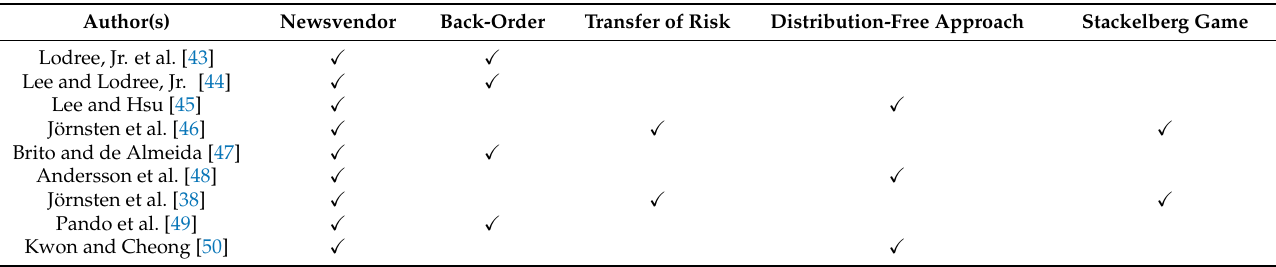
Table 1. Literature related to this